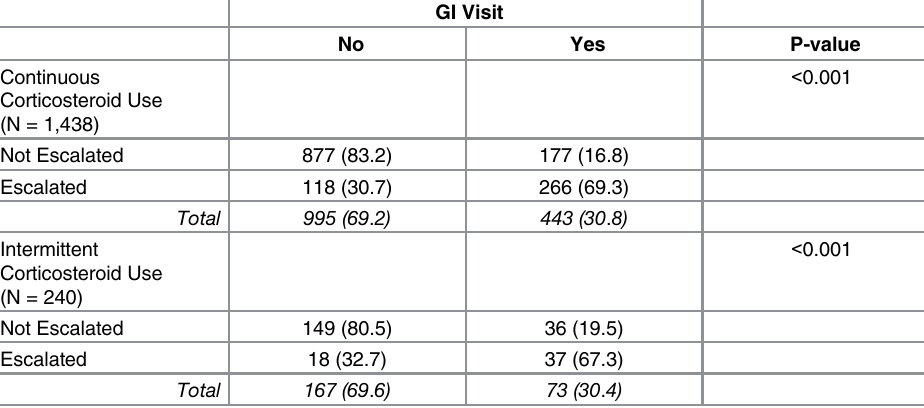
Table 3. Appropriate escalation to corticosteroid-sparing therapy vs. GI visit during the during corti- costeroid evaluation